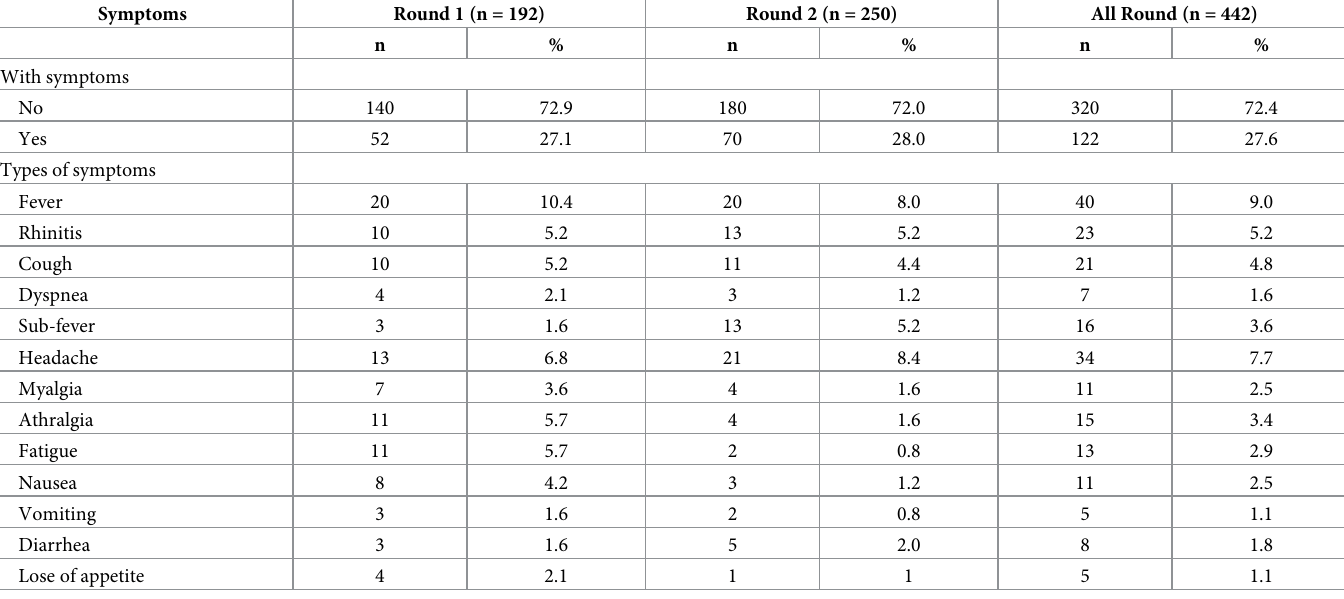
Table 4. Symptoms reported by indivuals positive for SARS-CoV-2 antibody within the last six months.